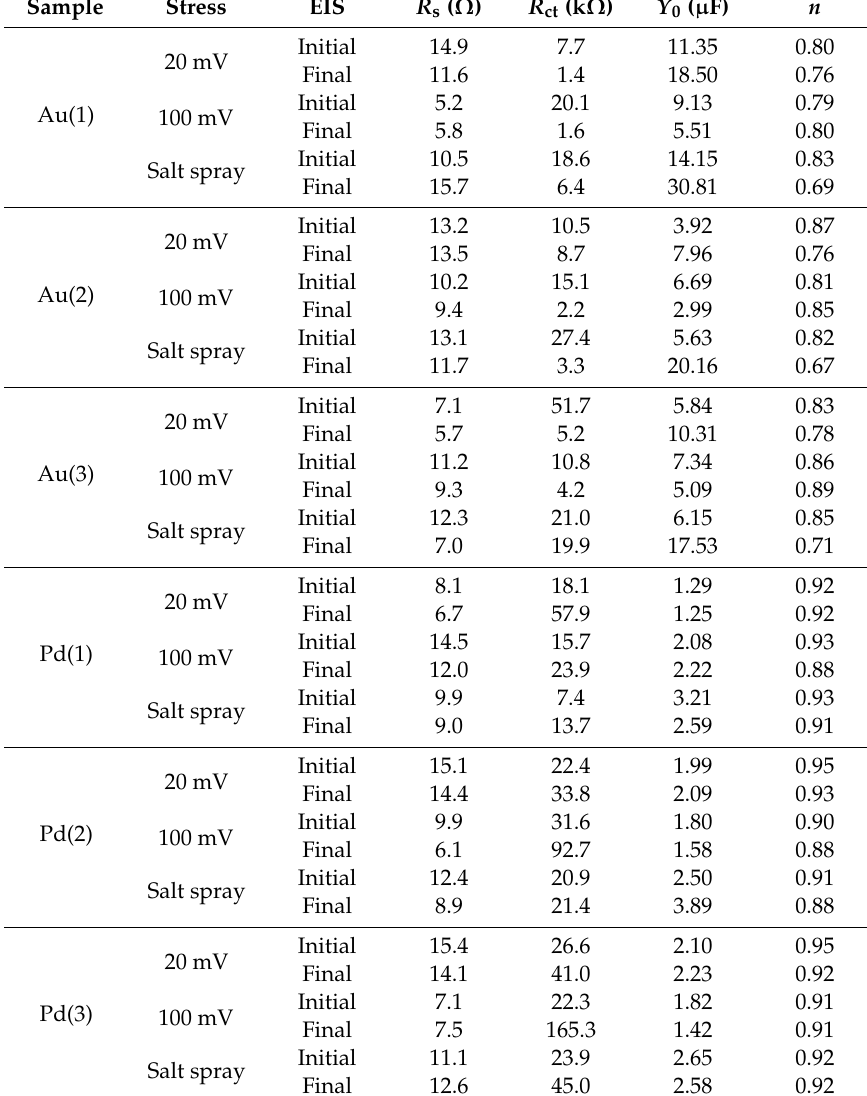
Table 2. Electrical parameters of equivalent circuit attained by fitting the EIS data.